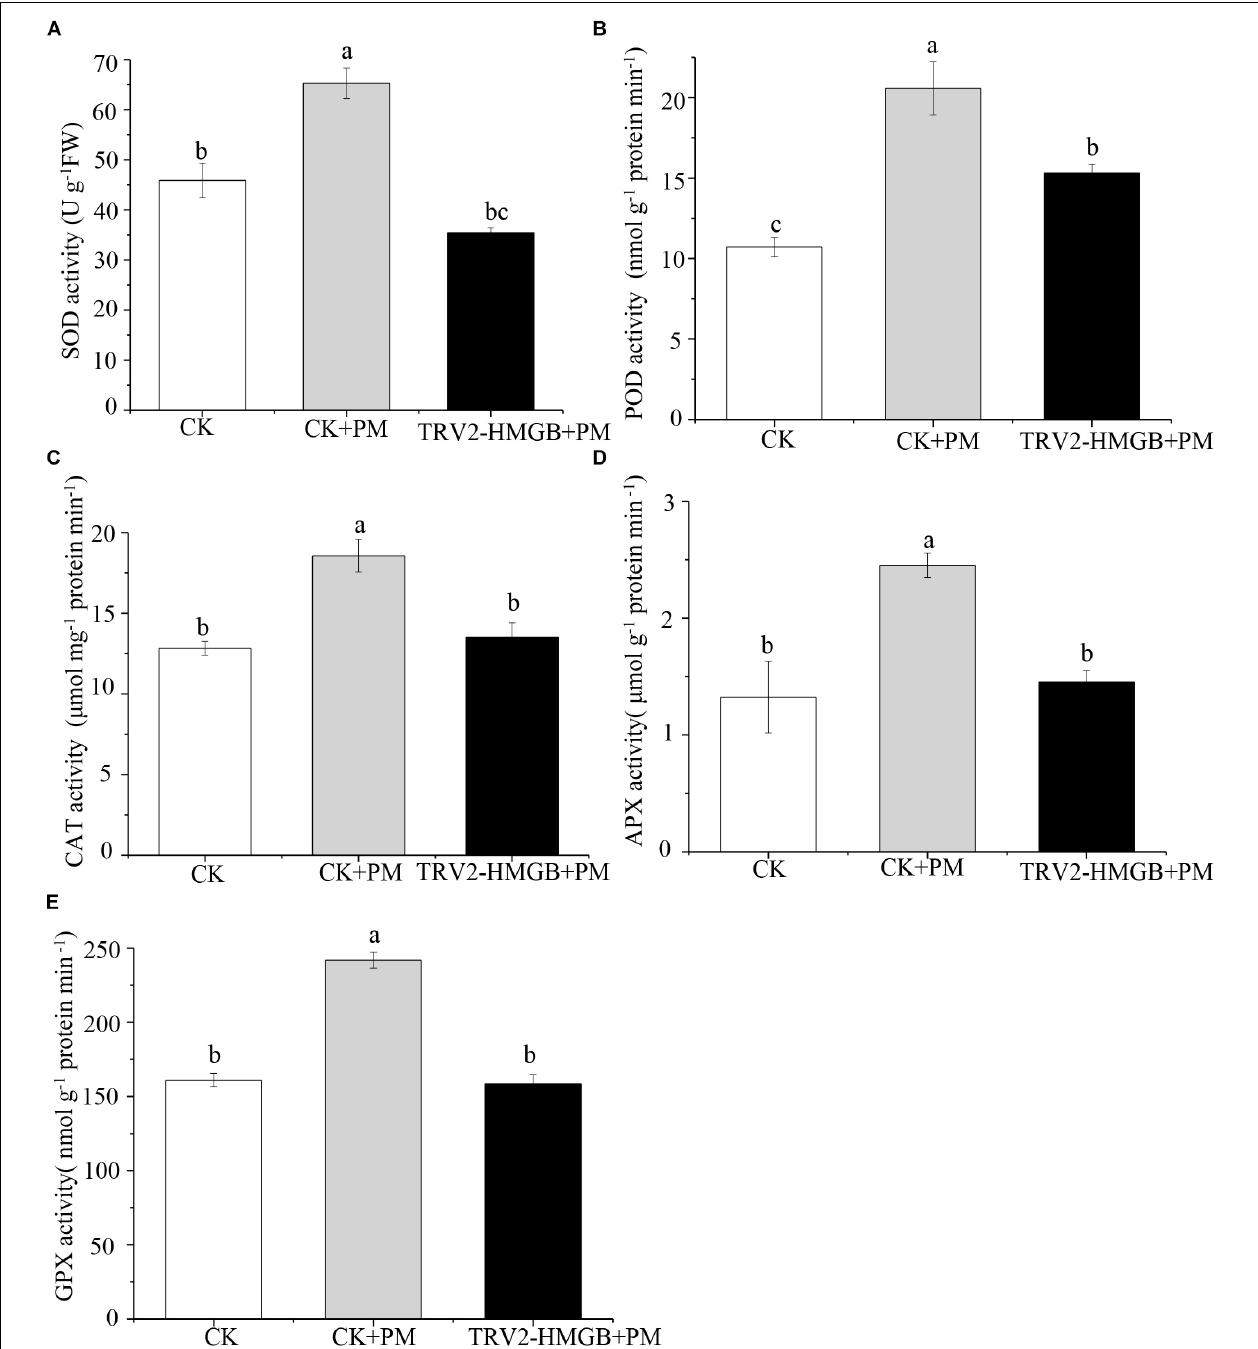
FIGURE 6 | Activity of antioxidant enzymes in CsHMGB -silenced leaves of “D0351” plants. (A) SOD activity. (B) POD activity. (C) CAT activity. (D) APX activity. (E) GPX activity. Data are the means of three replicates with SEs, and different letters indicate a significant difference ( p < 0.05 by Tukey’s